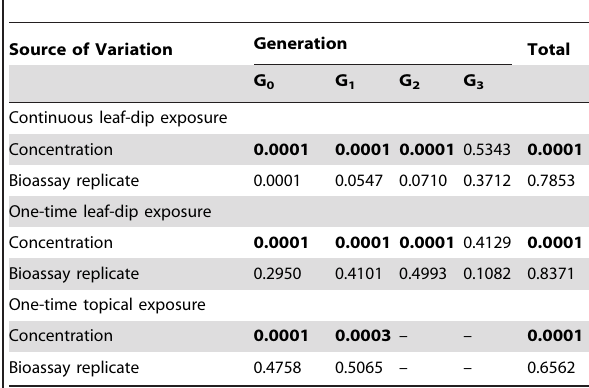
Table 1. P -values for a multigenerational experiment examining effects of imidacloprid concentration and experimental replicate (blocking factor) on M. persicae fecundity under laboratory